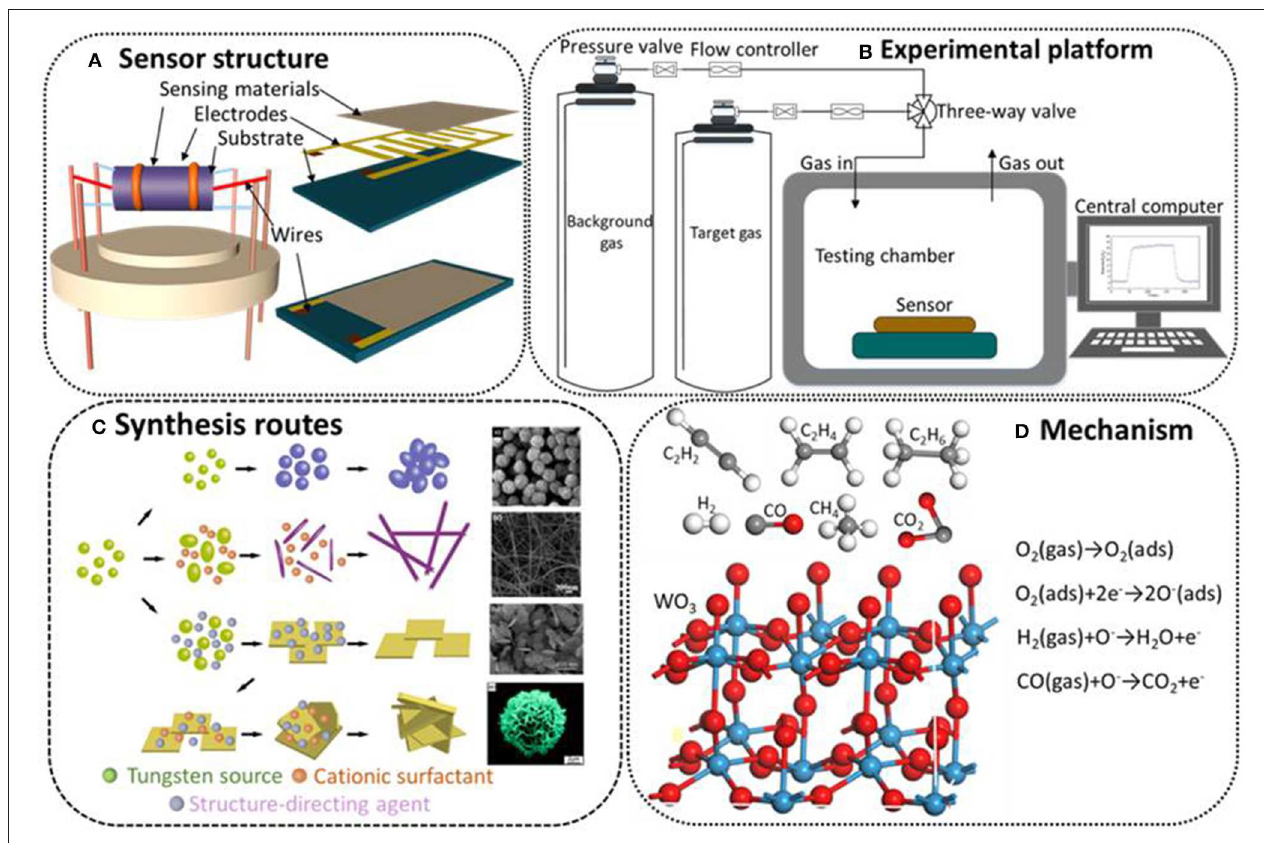
FIGURE 1 | (A) Schematic diagram of sensor structures. (B) Schematic illustration of a gas sensing experimental platform. (C) Synthesis routes of different morphologies. Nanoparticles. Reprinted with permission from Kwon et al. Copyright (2010) American Chemical Society. Nanowires. Reprinted with permission from Wang et al. Copyright (2008) American Chemical Society. Nanosheets. Reprinted with permission from Zhang et al. Copyright (2015) American Chemical Society. Nanoflowers. Reprinted with permission from Liu et al. Copyright (2010) American Chemical Society. (D) Gas sensing